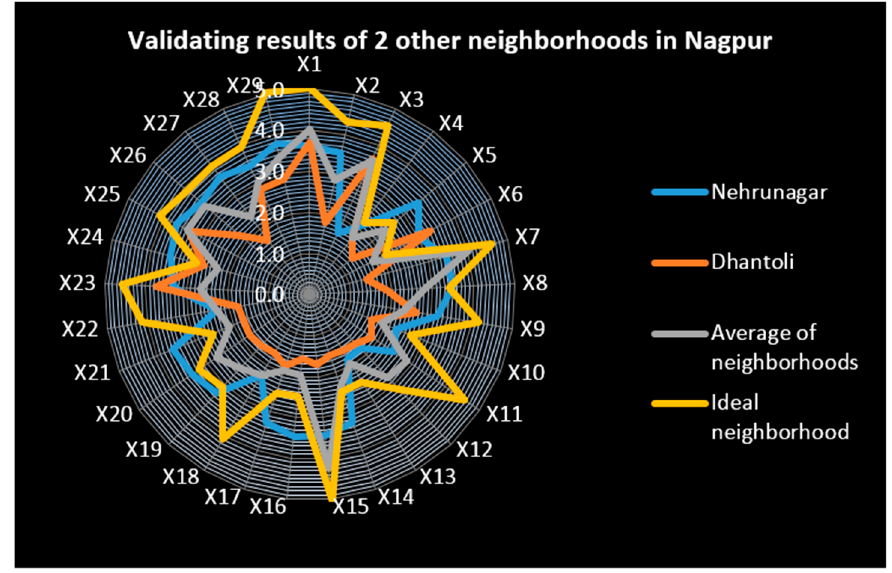
Figure 19. Validating average and ideal scores against values of Nehrunagar and Dhantoli.